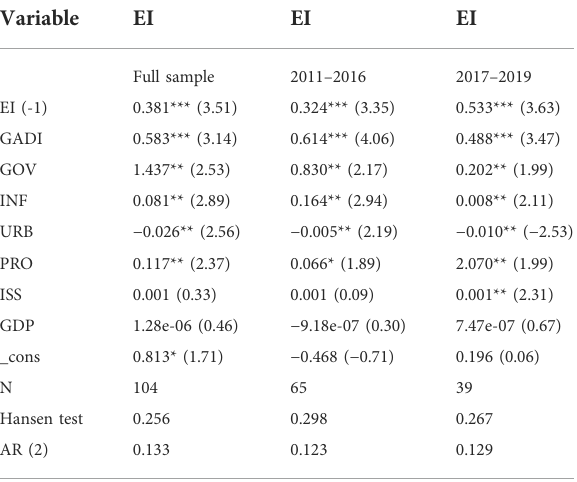
TABLE 8 Regression analysis results of the environmental impact of sub-dimensions of green